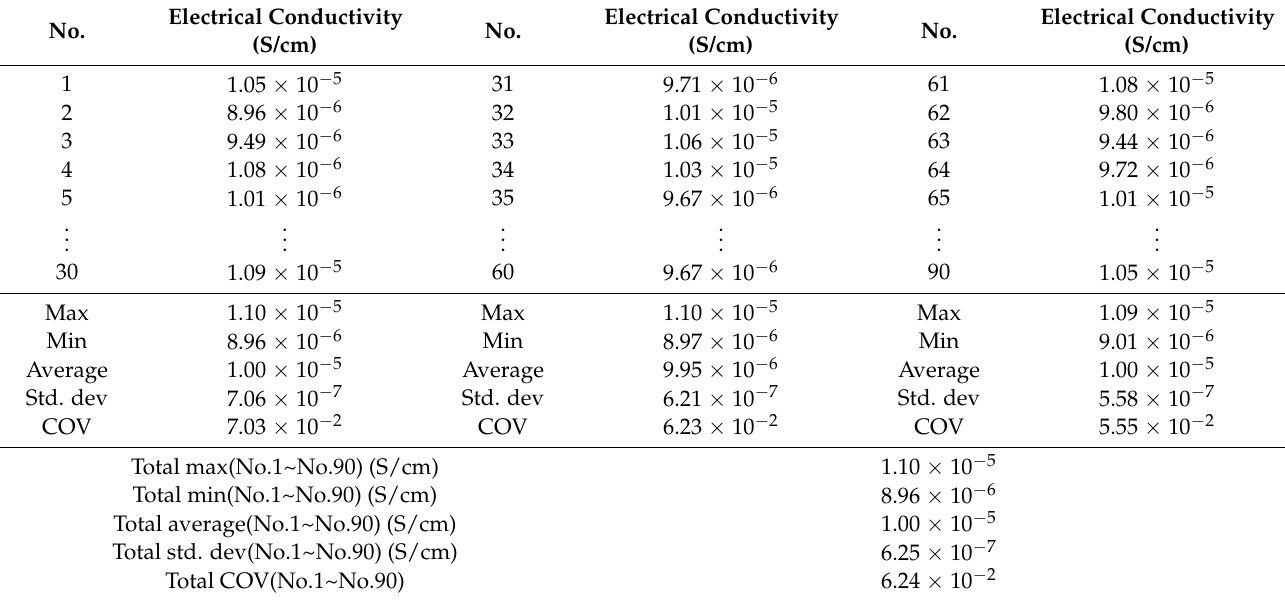
Table 7. Results of the electrical conductivity test for Case 2.